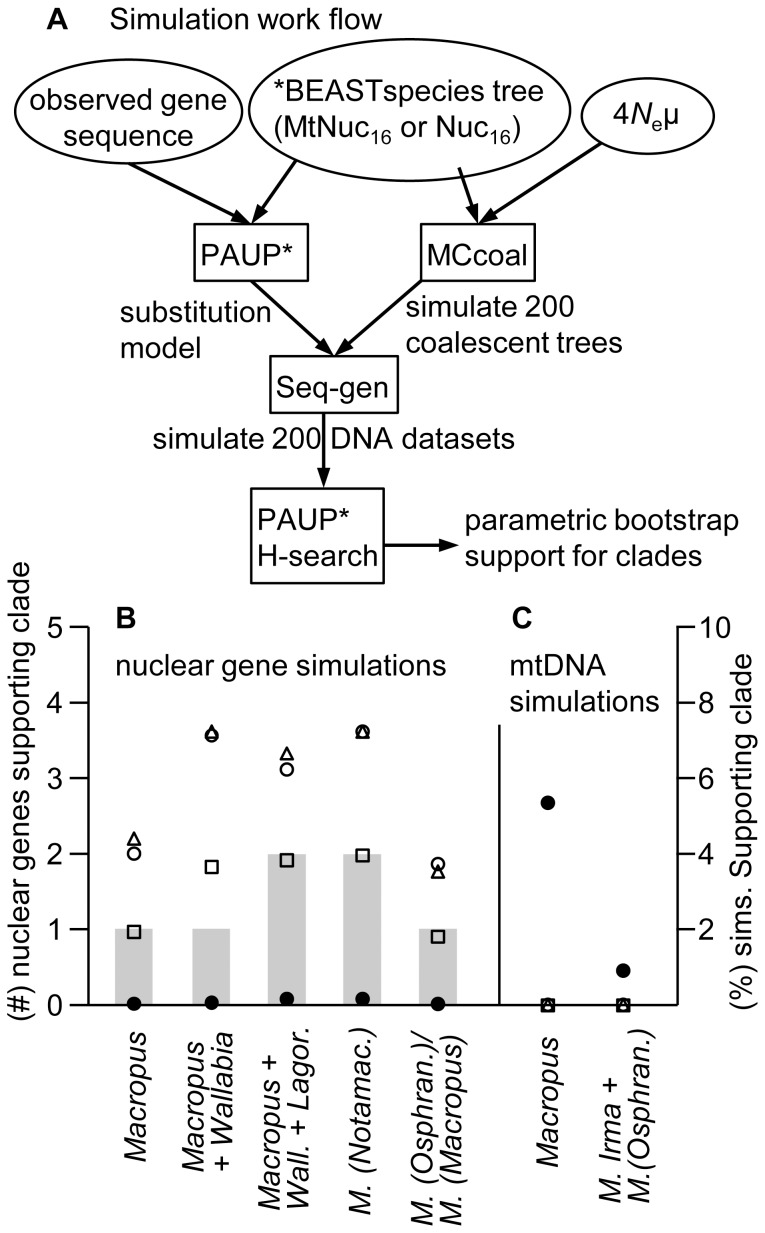
Macropodid clade support from datasets simulated under coalescence.(A) Simulation workflow. (B) Mean number of the five nuclear genes supporting each clade in maximum likelihood analyses of 200 simulations of the combined data *BEAST species tree for N
e values of 1,000 (triangle), 10,000 (open circle), 100,000 (square) and 1,000,000 (filled circle). For comparison, the grey bars show the number of genes supporting each clade on the observed data. (C) Percentage of ML analyses supporting each clade among 200 mtDNA simulations on the nuclear-only *BEAST species tree for N
e values set to mitochondrial equivalency for the same populations (one quarter of the corresponding nuclear values). Abbreviations: Lagor.; Lagorchestes, Wall.; Wallabia, M. (Notamac.); M. (Notamacropus), M. (Osphran.); M. (Osphranter).